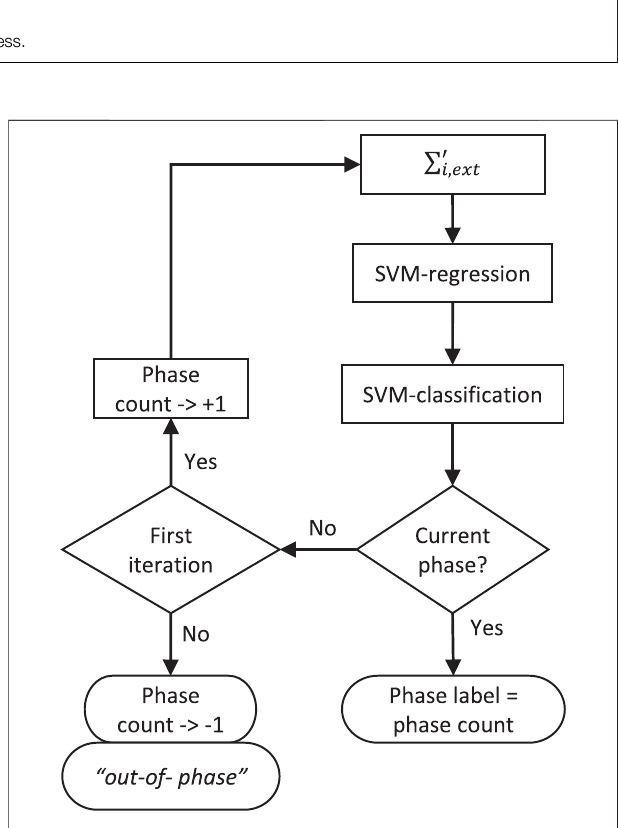
FIGURE 9 | Classi fi cation decision logic for online phase